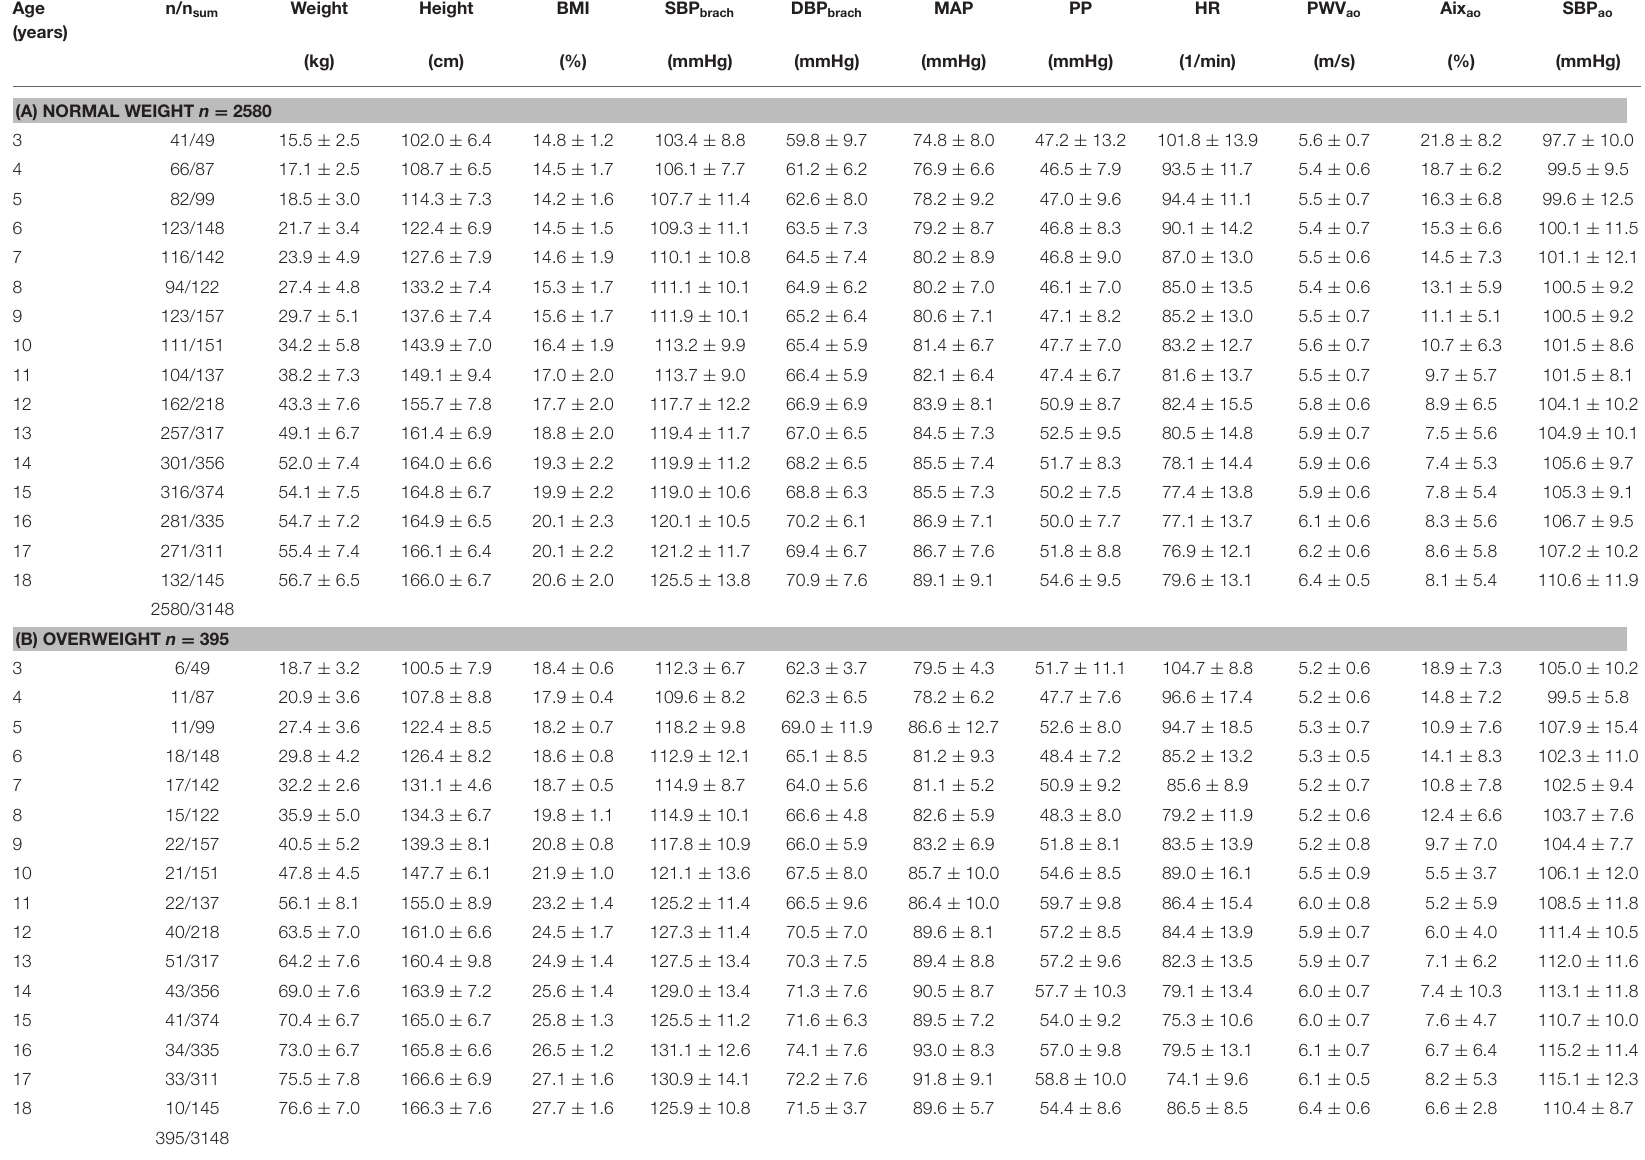
TABLE 2 | Characteristics for